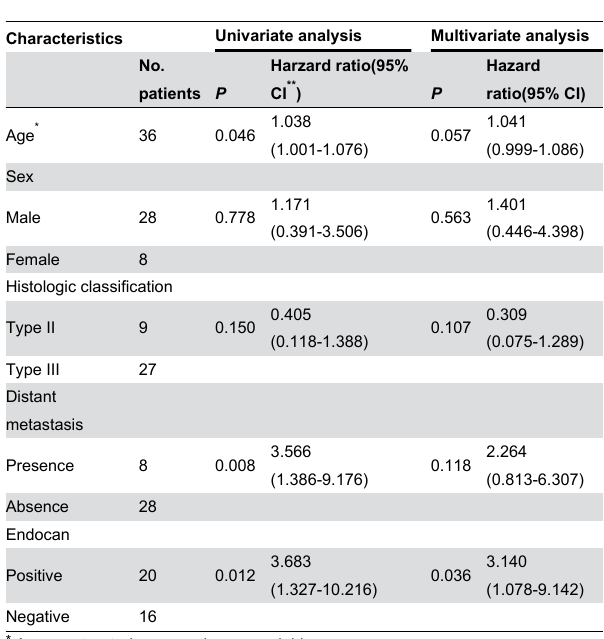
Table 2. Univariate and multivariate analyses of factors associated with survival in patients with